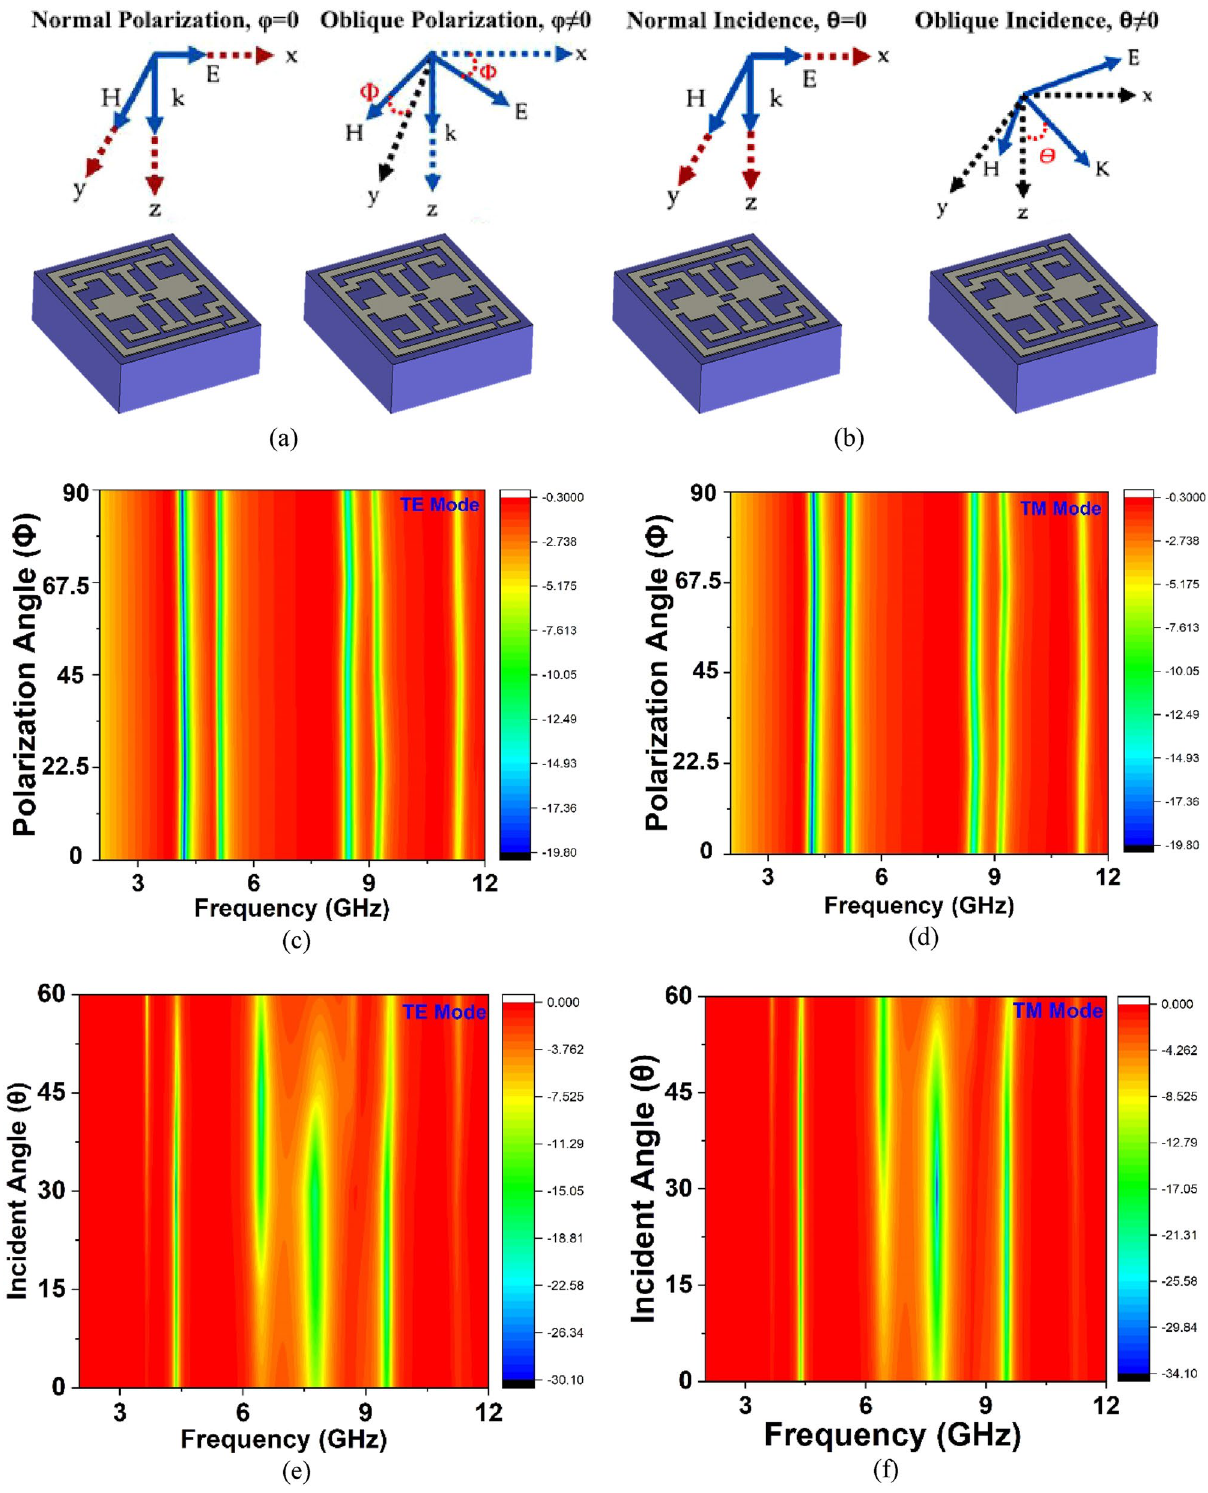
Figure 12. Presentation of ( a ) normal and oblique polarization angle, ( b ) normal and oblique incident angle, ( c ) polarization angle at TE mode, ( d ) polarization angle at TM mode, ( e ) incident angle at TE mode ( f ) Incident angle at TM mode (CST STUDIO SUITE 2019, https:// www. 3ds. com/ produ cts- servi ces/ simul ia/ produ cts/ cst- studio- suite) 30